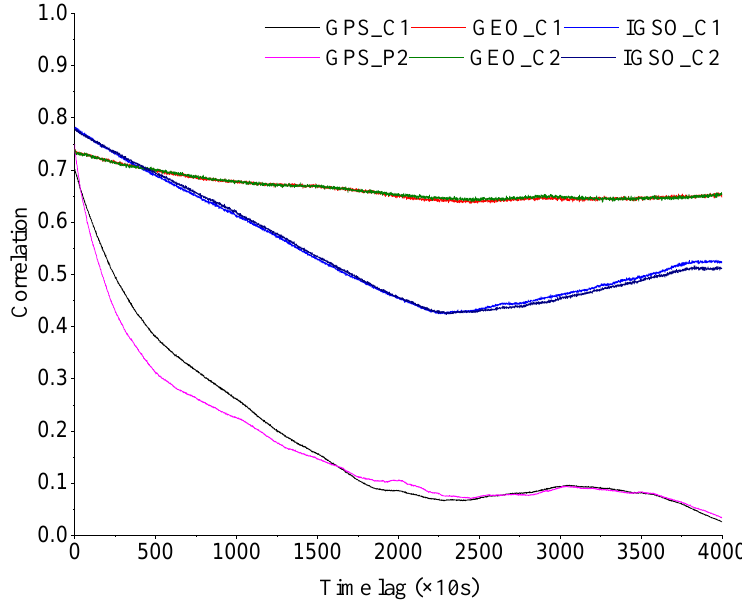
Figure 8. ComNav code measurement time correlations for GPS, and BeiDou GEO and IGSO satellites with a sampling interval of 10 s.